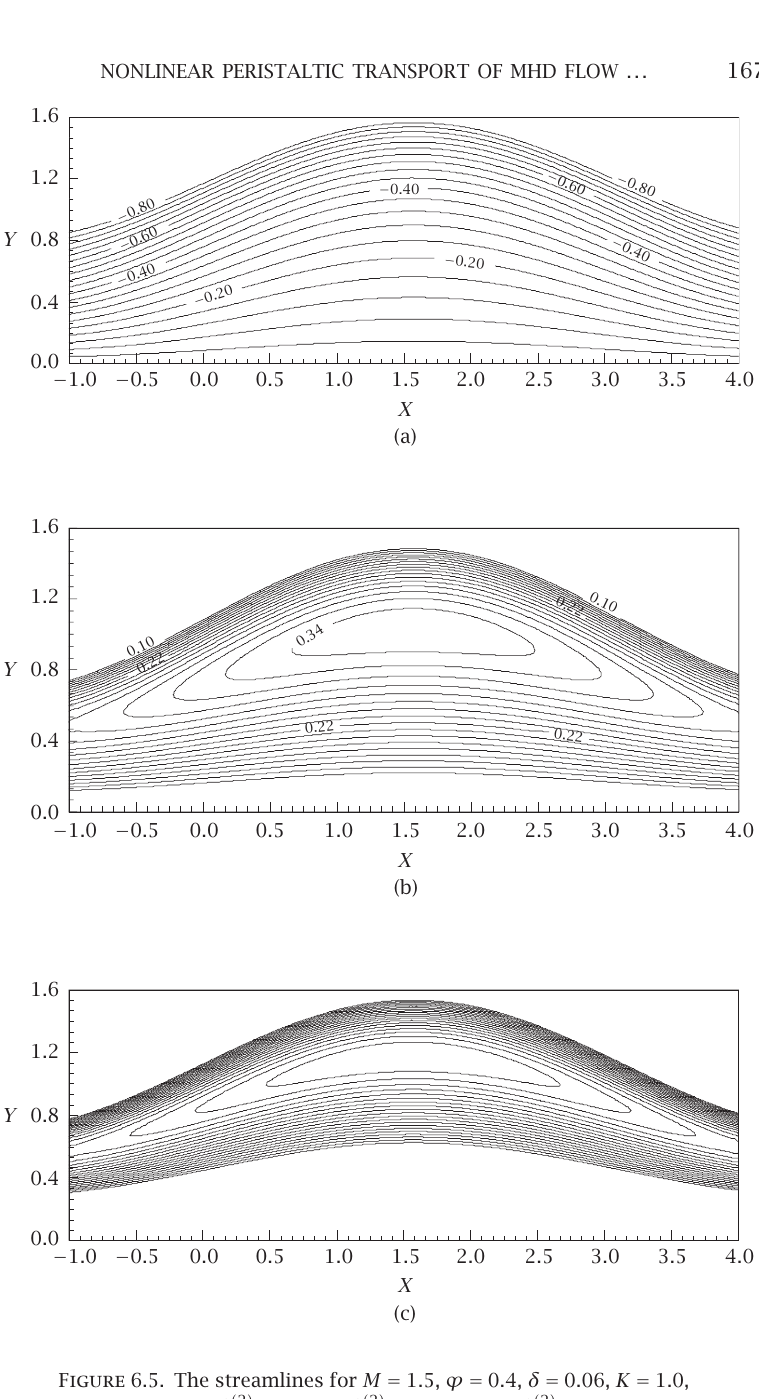
Figure 6.5 . The streamlines for M = 1 . 5, ϕ = 0 . 4, δ = 0 . 06, K = 1 . 0, and Re = 0 at (a) θ ( 2 ) = 0 . 4, (b) θ ( 2 ) = 1 . 2, and (c) θ ( 2 ) = 1 .